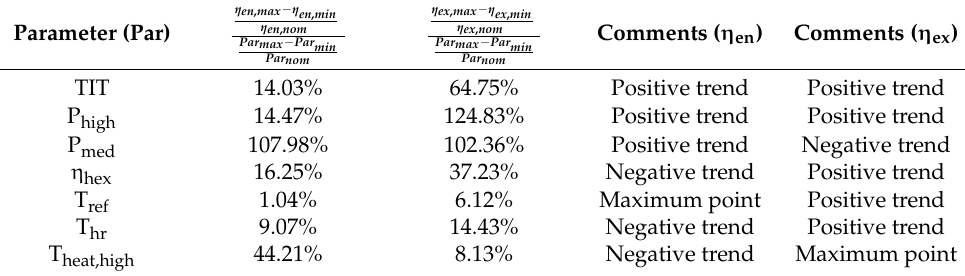
Table 5. Ratios of the efficiency difference to the parameter range (sensitivity